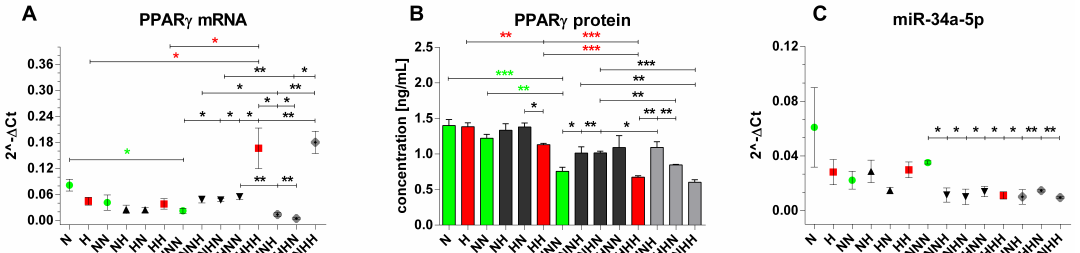
Figure 5. PPAR γ (mRNA and protein) and mir-34a-5p expression profiles during adipogenesis in chronic / intermittent normoglycemic (N) and hyperglycemic (H) conditions. ( a) The relative levels of mRNA expression and ( b ) protein concentration of PPAR γ , as well as ( c ) the relative levels of miR-34a-5p expression evaluated after completion of proliferation, di ff erentiation and maturation of visceral cells. Data are expressed as mean ± SEM. Di ff erences in expression levels between two particular culture variants were evaluated using a two-tailed t-test. One-way ANOVA with a post hoc Tukey test was used for calculation of statistical significance of changes observed during ADG in NG (NN vs N, NNN vs N, NNN vs NN) and HG (HH vs H, HHH vs H, HHH vs HH). *** p ≤ 0.001; ** p ≤ 0.01; * p ≤